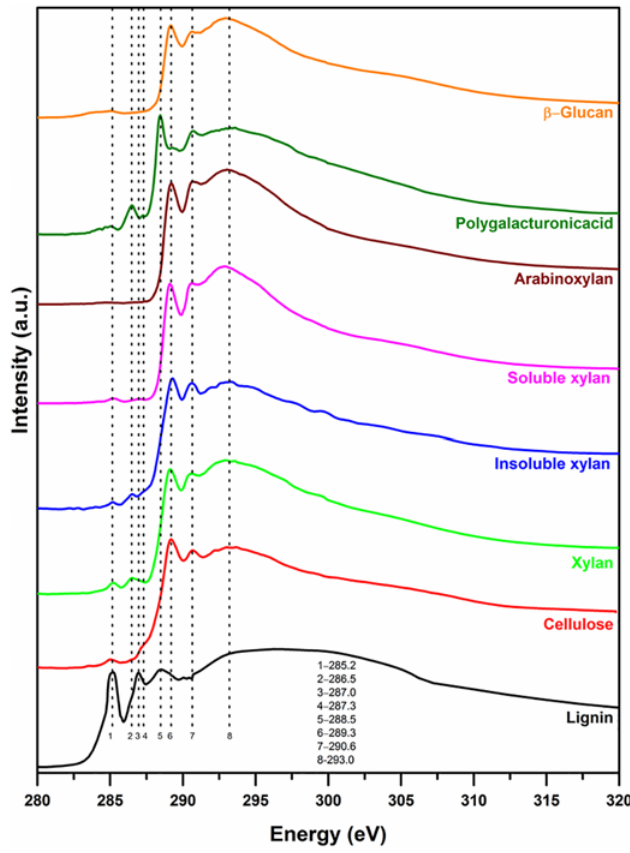
Fig 1. Carbon 1s soft X-ray absorption spectra of lignin, cellulose, xylan, arabinoxylan, polygalacturonic acid, and β -glucan.